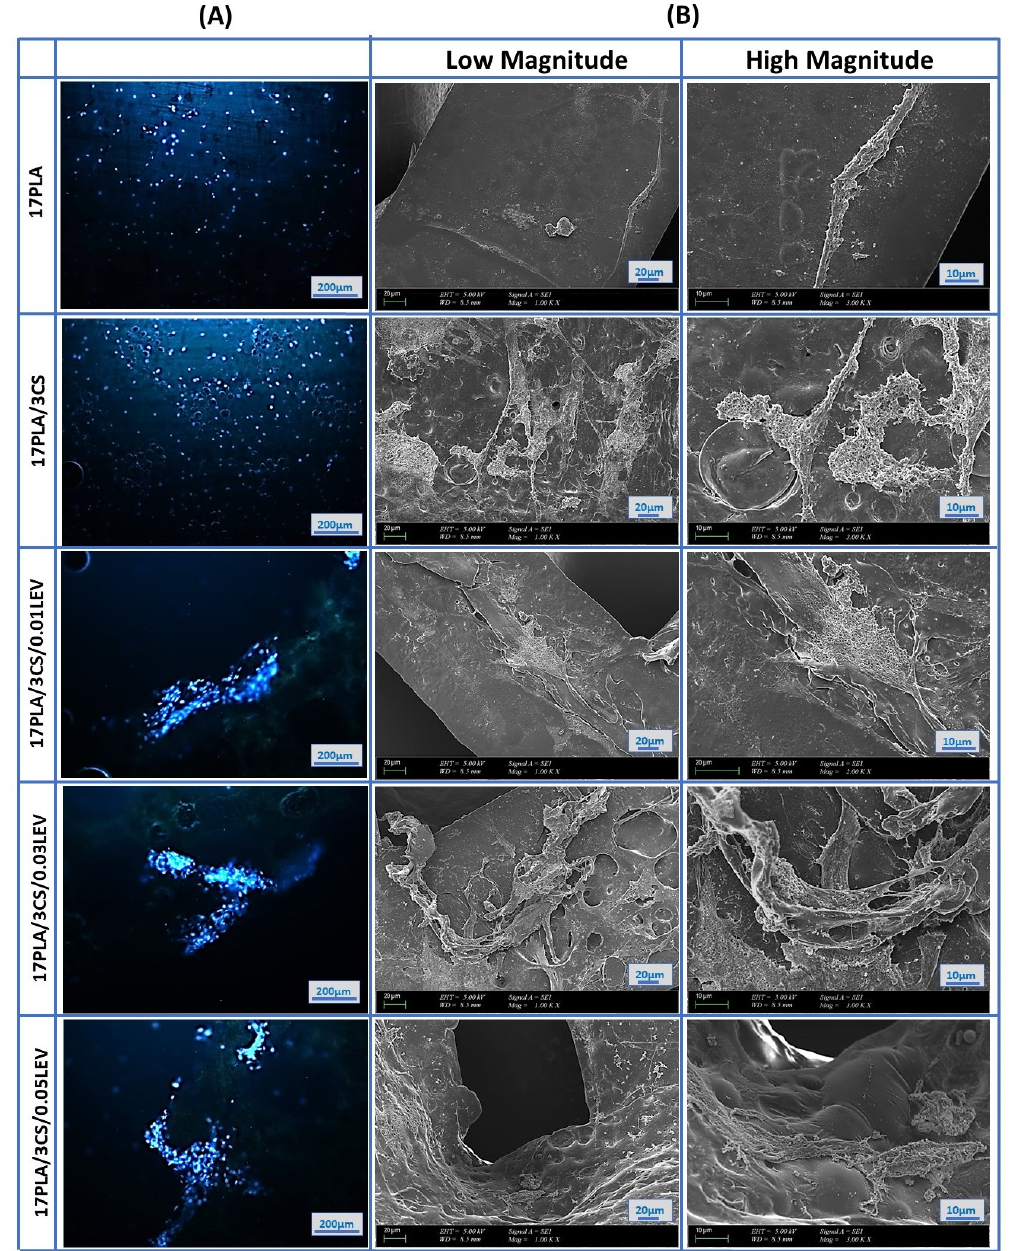
Figure 10. Fluorescence microscopy images of human mesenchymal stem cells that nucleus stained with DAPI on scaffolds after 7 days of incubation ( A ), and SEM images of mesenchymal stem cells scaffolds ( B ).